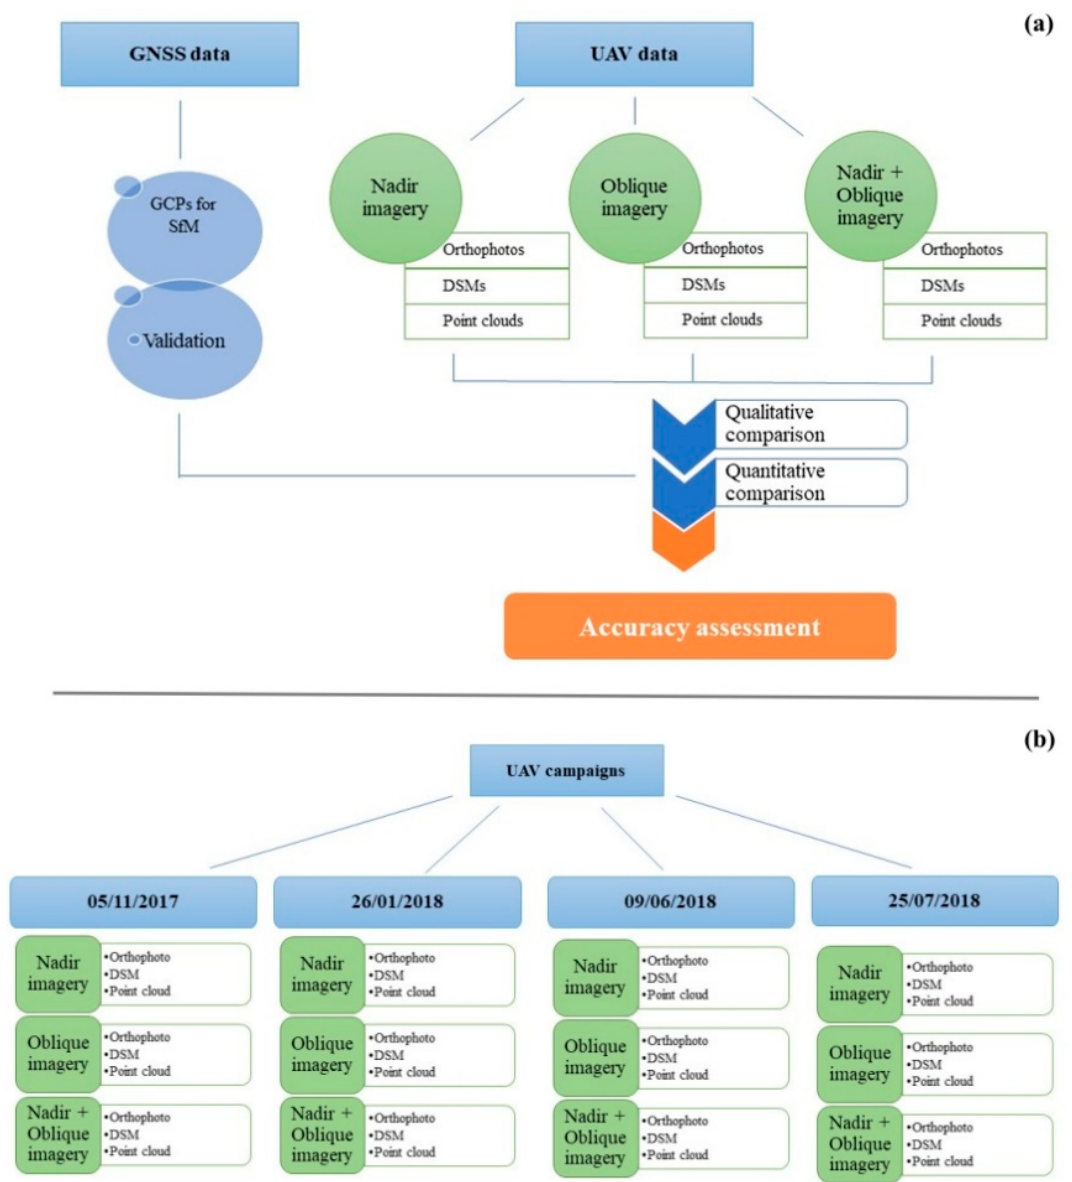
Figure 4. ( a ) Flowchart representing the applied methodology. ( b ) The derived products of each UAV campaign. The UAV imagery organized in subcategories of nadir imagery, oblique imagery and a combination of nadir and oblique imagery was subjected to SfM photogrammetric processing into Agisoft Photoscan software. Specifically, the alignment of the images was performed in accordance with the highest-quality option, which contribute to a more precise estimation of the camera positions [33]. Furthermore, the specific setting results in the processing of UAV images in their original size, while the images were upscaled by